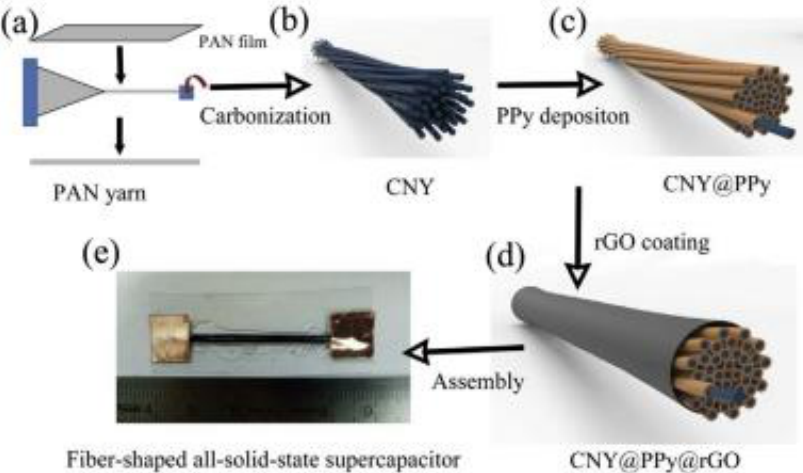
Figure 23. Fabrication process of ( a – d ) fiber materials and ( e ) fiber-shaped all-solid-state supercapacitor. (a) Schematic illustration of the PAN nanofibers yarn fabrication; sketch of the ( b ) carbonized carbon